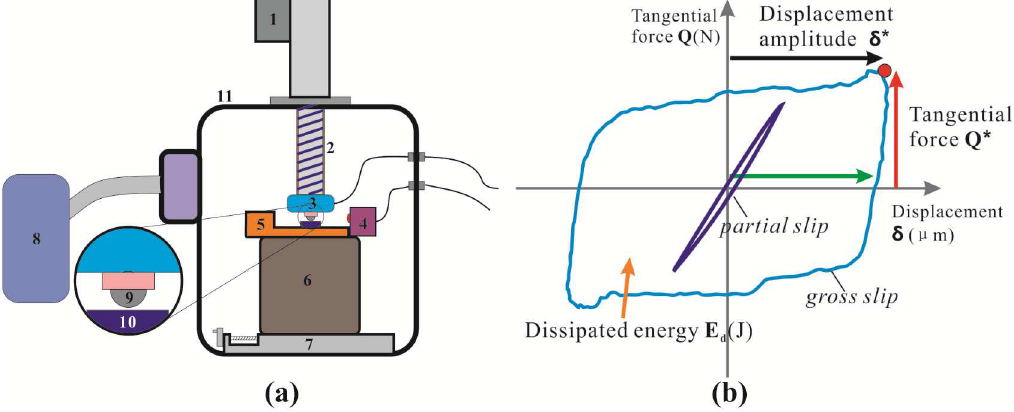
Fig 2. Schematic view of experimental set-up (a) and fretting loop analysis